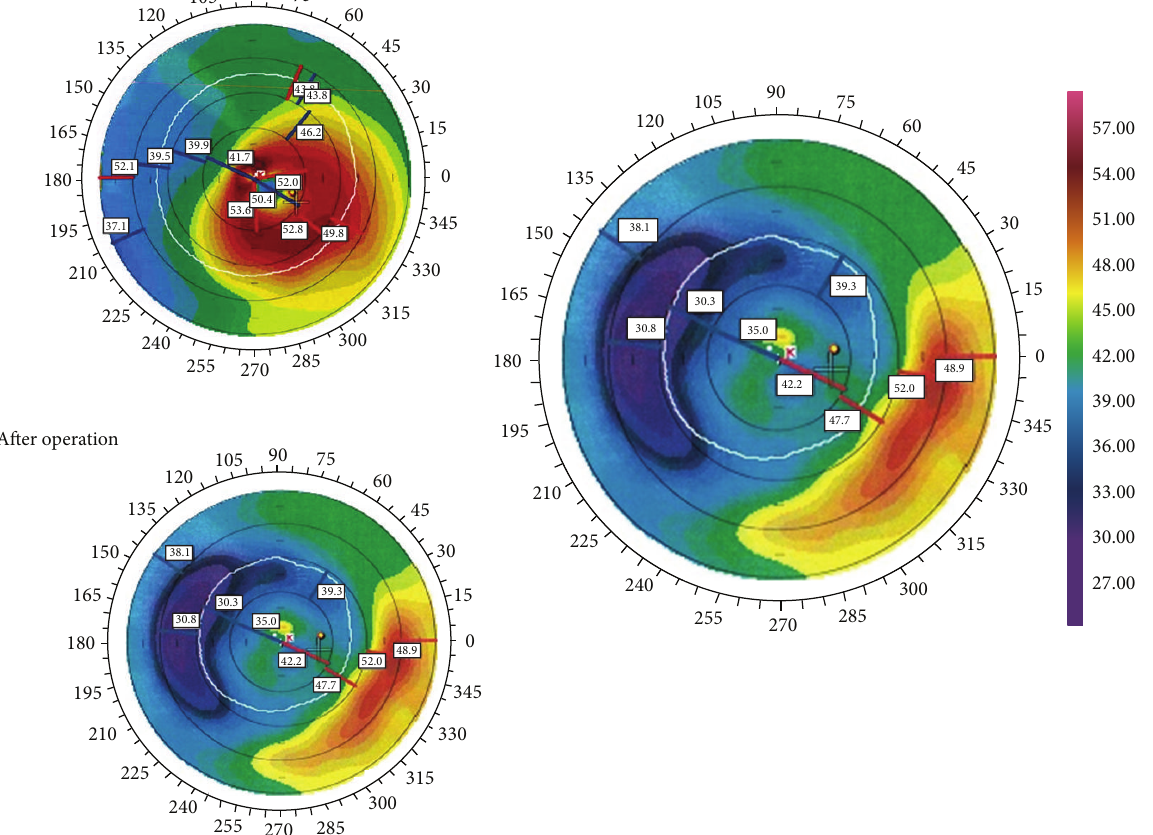
Figure 3: Preoperative (top left) and postoperative topographies at 3 months (top right) after Keraring 355 ∘ ICR implantation.